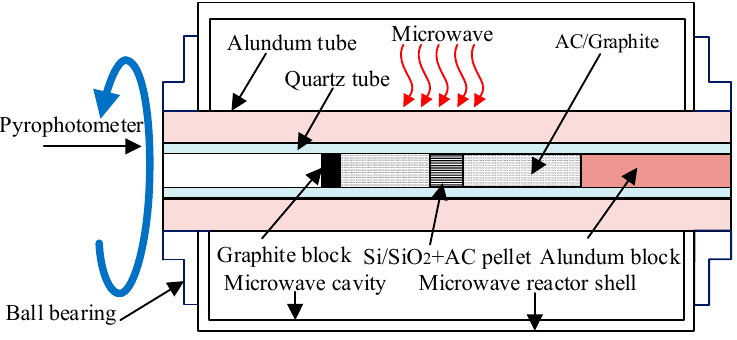
Figure 1. Reaction set-up for silicon carbide (SiC) synthesis in the rectangular multimode microwave cavity (RMMC) and cylindrical multimode microwave cavity (CMMC) reactors.